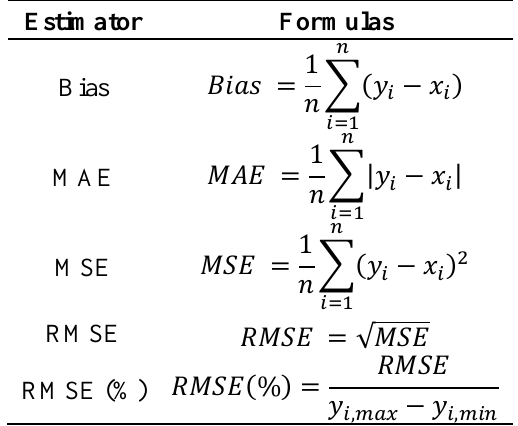
Table 1. Error estimators used in this study. MAE, mean absolute error; MSE, mean square error; RMSE, root mean square